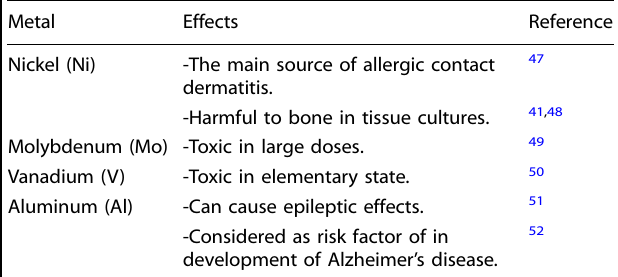
Table 1. Effects on the human body by metal ions released during the corrosion of various implanted